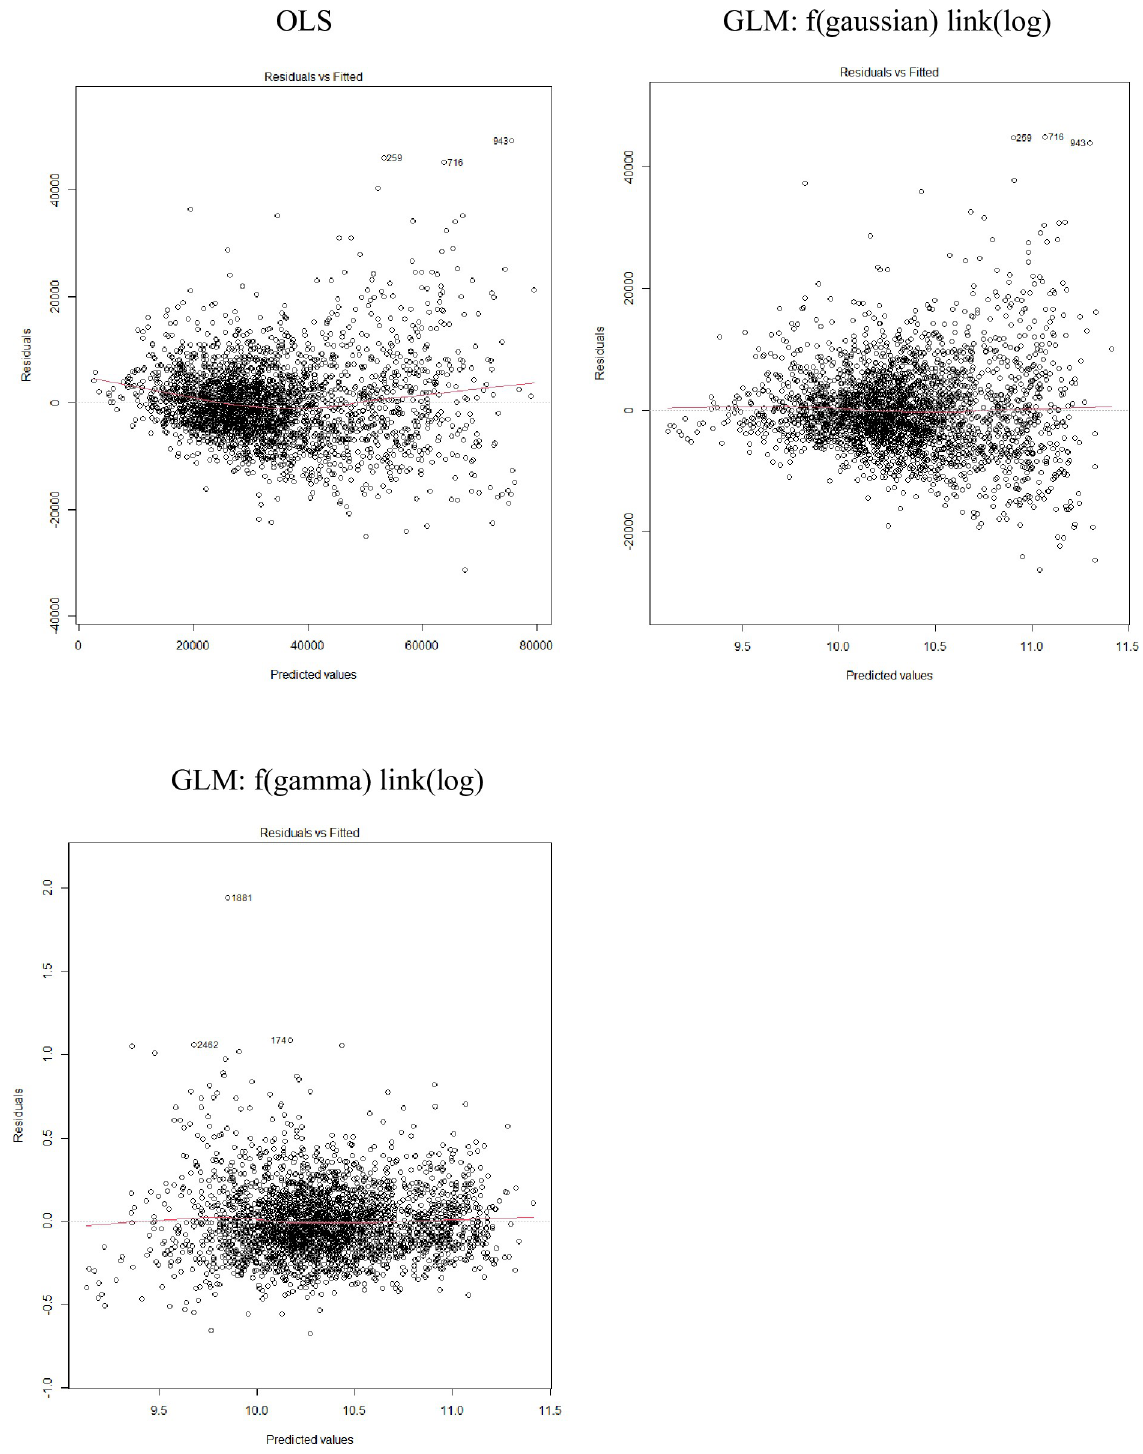
Fig 4. Residuals vs. fitted values plots for Hawaii longline fishery trip cost models � . � Residuals represent deviance residuals for GLM. The red line represents the average value of the residuals at each value of fitted value.